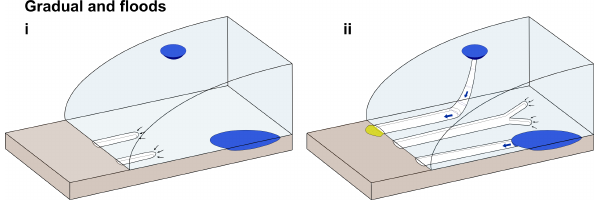
Figure 18. For the southern Laurentide region we consider grad- ual headward erosion as the usual mechanism, but with some floods down selected valleys – note the potential for stored water to cut their own valleys (e.g. supraglacial lake drainage example) or to drain along pre-existing corridors that may have tapped into a reser- voir (e.g. subglacial lake